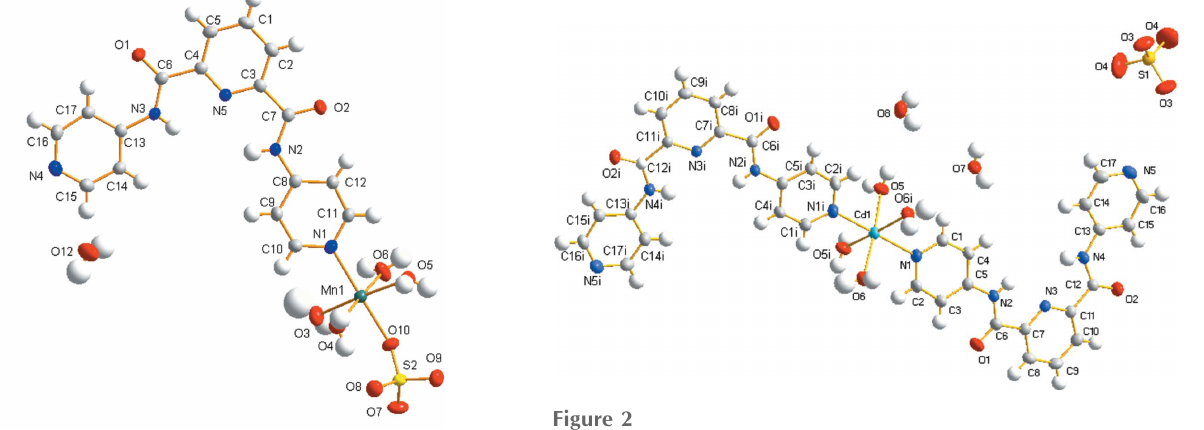
Figure 1 The molecular structure of the title complex (I) with displacement ellipsoids shown at the 50% probability